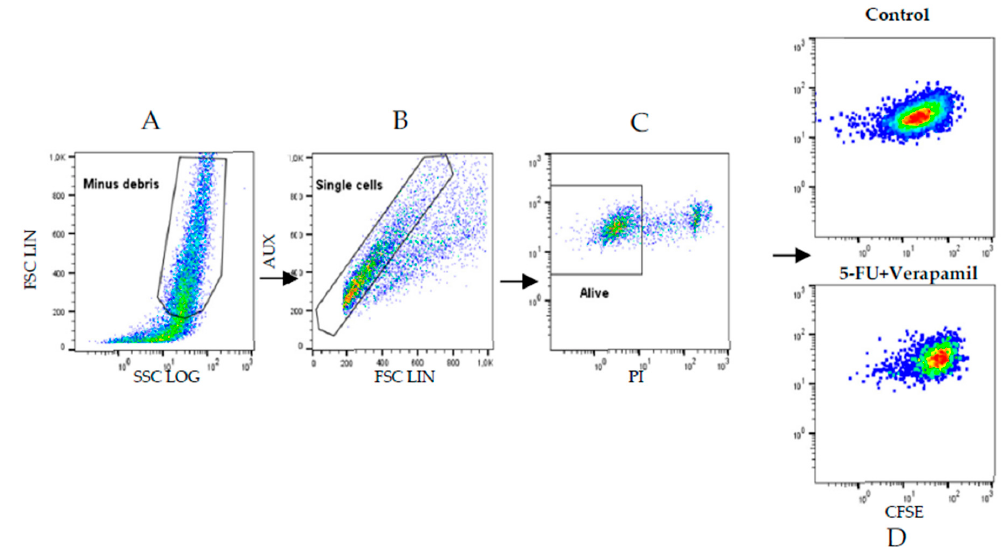
Figure 14. Flow cytometry gating strategy used in the carboxyfluorescein succinimydil ester (CFSE) proliferation assay of MCF-7 cells. ( A ) The gate separated MCF-7 cells from cellular debris, whereas in ( B ) single cells are gated, thus excluding aggregates. ( C ) Dead cells were excluded by PI incorporation, and ( D ) represents cell fluorescence due to CFSE staining in non-treated (control) or 5-FU + Verapamil (treated cells), as indicated.